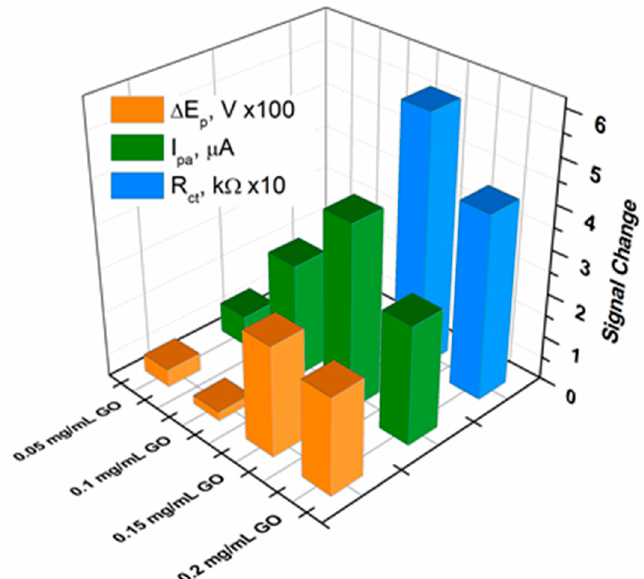
Figure 13. Signal change in peak current intensities (Ipa), peak-to-peak separation potentials ( Δ Ep) and charge transfer resistance values obtained from EIS measurements (Rct, quality of fitting χ 2 = 0.051 ± 0.022) after hybridization with 100 nM DNA target in respect with the measured values after ssDNA probe adsorption.